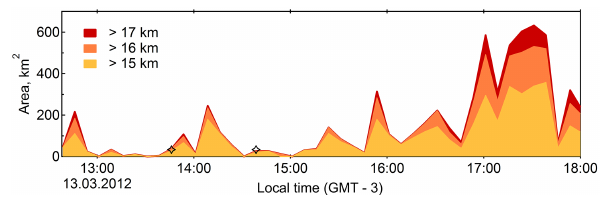
Figure 6. Temporal evolution of cumulative overshooting area at different levels of TTL recorded by IPMet radar on 13 March within its 240km range (10dBZ reflectivity threshold). The black stars mark the timing of overshooting cells shown in Figs. 5 and